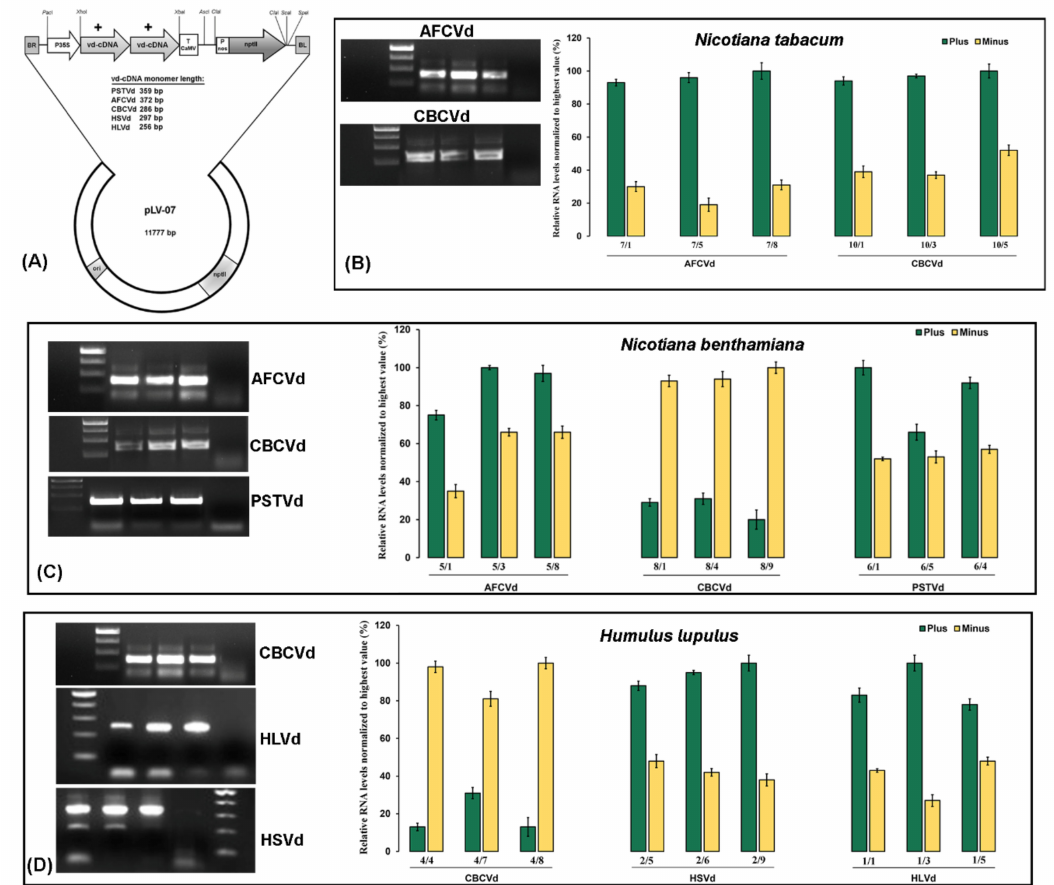
Figure 1. Schematic representation of dimeric infectious constructs, detection and quantification of viroids. ( A ) Schematic diagram of a plasmid containing the shown viroid ( + ) dimer created by cDNA cloning in SacI restriction site. The viroid ( + ) dimer was re-cloned from pPCR-Script to Xho I –Xba I sites of intermediary vector pLV-68. The final modified binary expression cassette harboring CaMV 35S promoter, viroid cDNA and CaMV terminator was cloned into Pac I and Asc I sites of the plasmid pLV-07. ori: origin of replication; kanR: kanamycin resistance gene; RB: left border of T-DNA; RB: right border of T-DNA; T CaMV: terminator from cauliflower mosaic virus; Pnos: nopalin synthase promoter; nptII: neomycin phosphotransferase II. RT-PCR-based detection and strand-specific real-time RT-qPCR quantification of viroids in single infected Nicotiana tabacum ( B ), N . benthamiana ( C ) and hop ( D ) plants. The gel picture shows three biological replicates of infected samples (with amplification) and a negative control (without amplification). The numbers under the bar indicate plant sample codes. All samples were normalized to the strand with a higher level (100%) and relative quantities were calculated using target-specific amplification e ffi ciencies. Each column represents the mean ± SD of three technical replicates of single infected